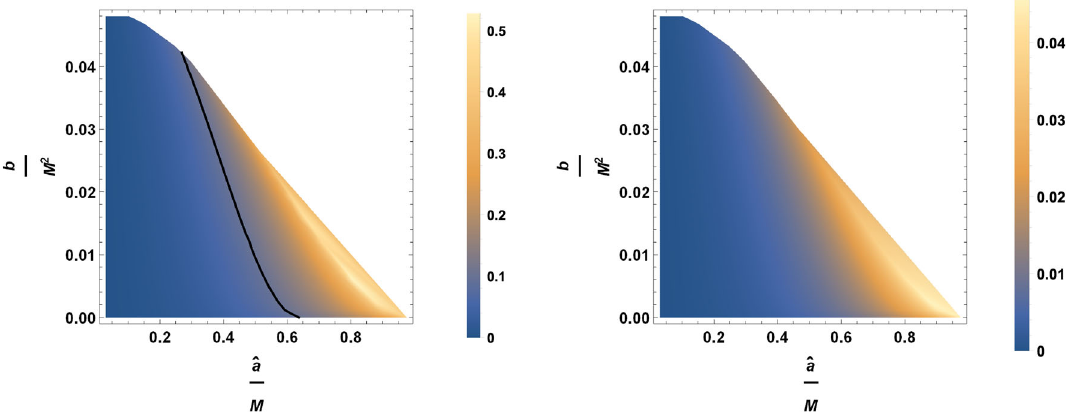
Fig. 20 For the left panel the inclination angle is 90 ◦ and for the right panel the inclination angle is 17 ◦ . The black solid lines correspond to (cid:5) C = 0 . 1